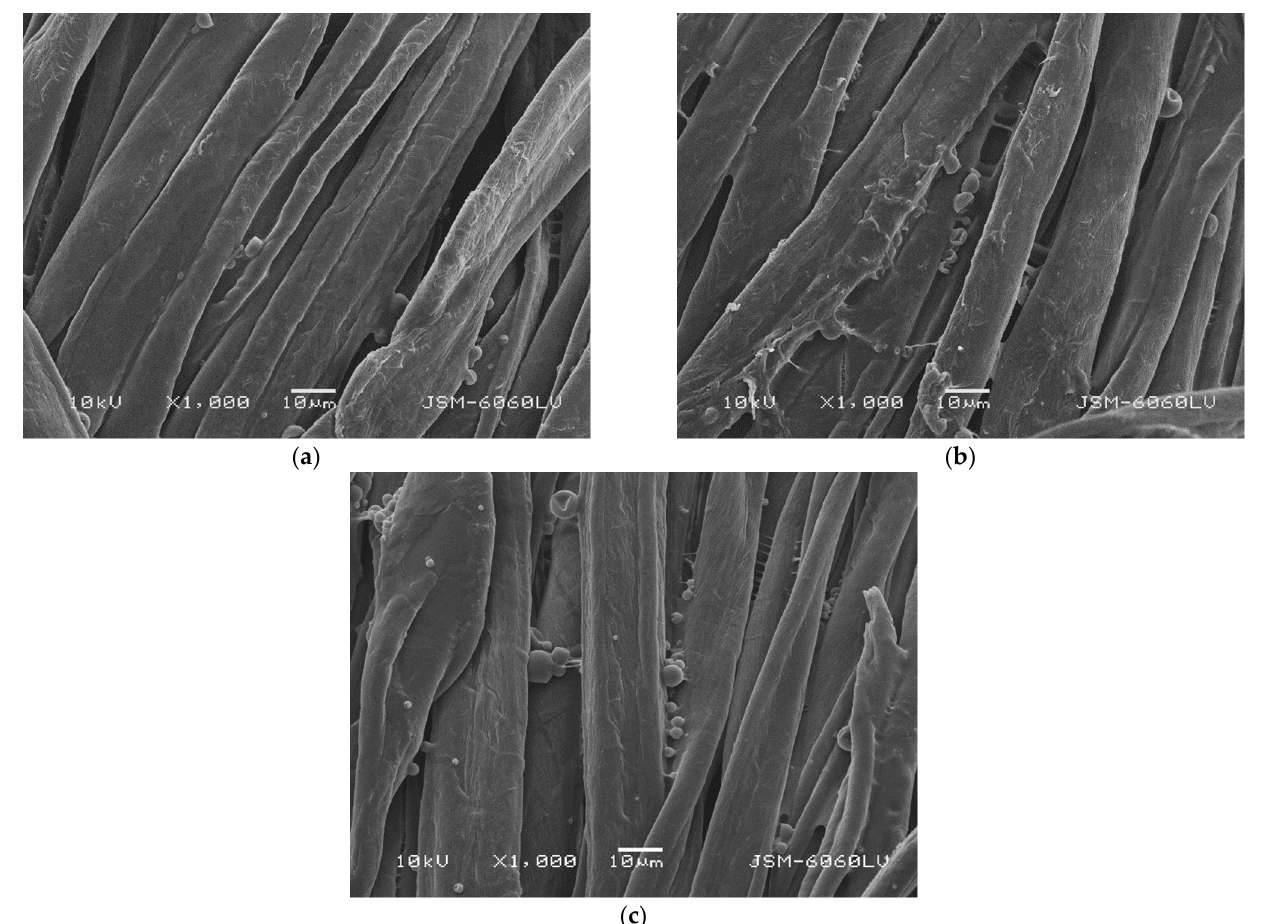
Figure 6. SEM images of ( a ) untreated and FCM-coated sample, ( b ) O 2 plasma-treated and FCM-coated sample, and ( c ) N 2 plasma treated and FCM-coated sample after tenth wash.